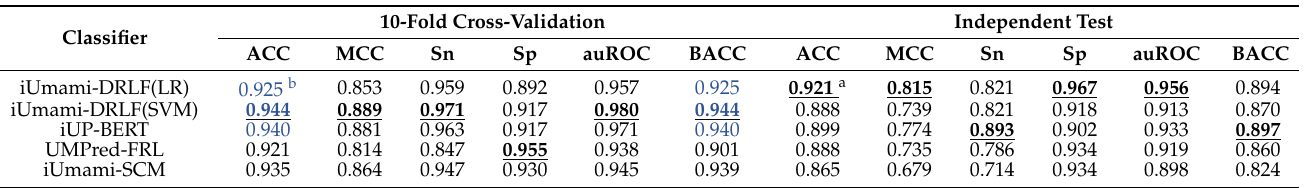
Table 3. Results of 10-fold cross-validation and independent testing of iUmami-DRLF and other existing